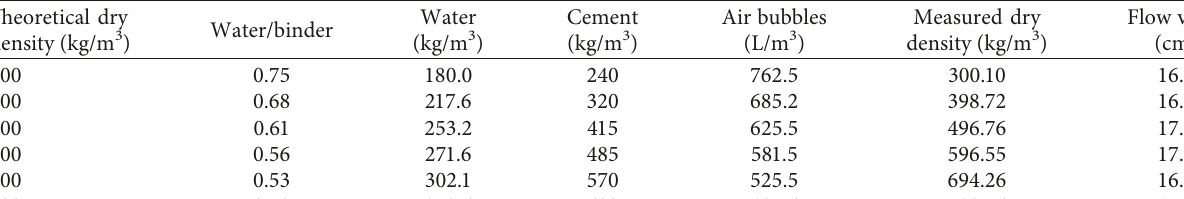
Table 1: Mix proportions and major parameters of foamed concrete.